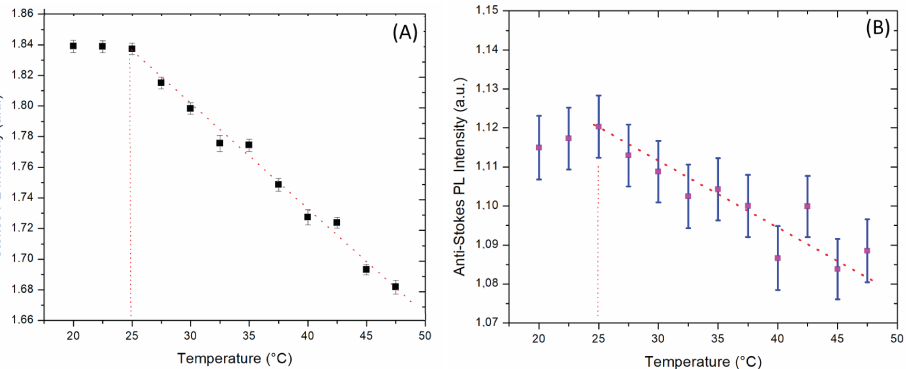
Figure 6. Variation of Stokes ( A ) and anti-Stokes ( B ) fluorescence intensities of RhB in fluorocarbon oil under 3.5 mW power illumination. We observe two temperature intervals: (i) below 25 ◦ C, where the fluorescence intensity is practically constant, (ii) and above 25 ◦ C, where the fluorescence intensity decreases linearly versus temperature with a temperature sensitivity of about − 0.4%/ ◦ C for Stokes fluorescence and − 0.2%/ ◦ C for anti-Stokes fluorescence.